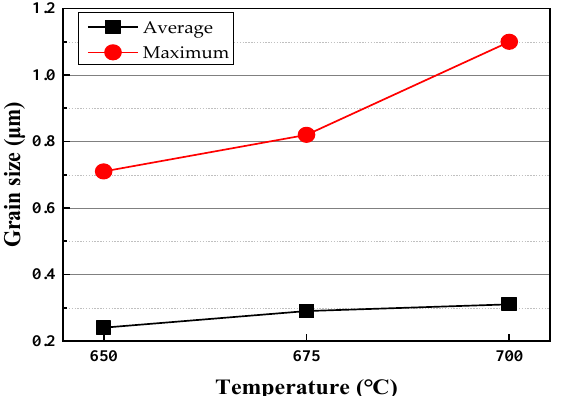
Figure 9. Changes in the average grain size and maximum grain size of austenite grains with annealing temperature.